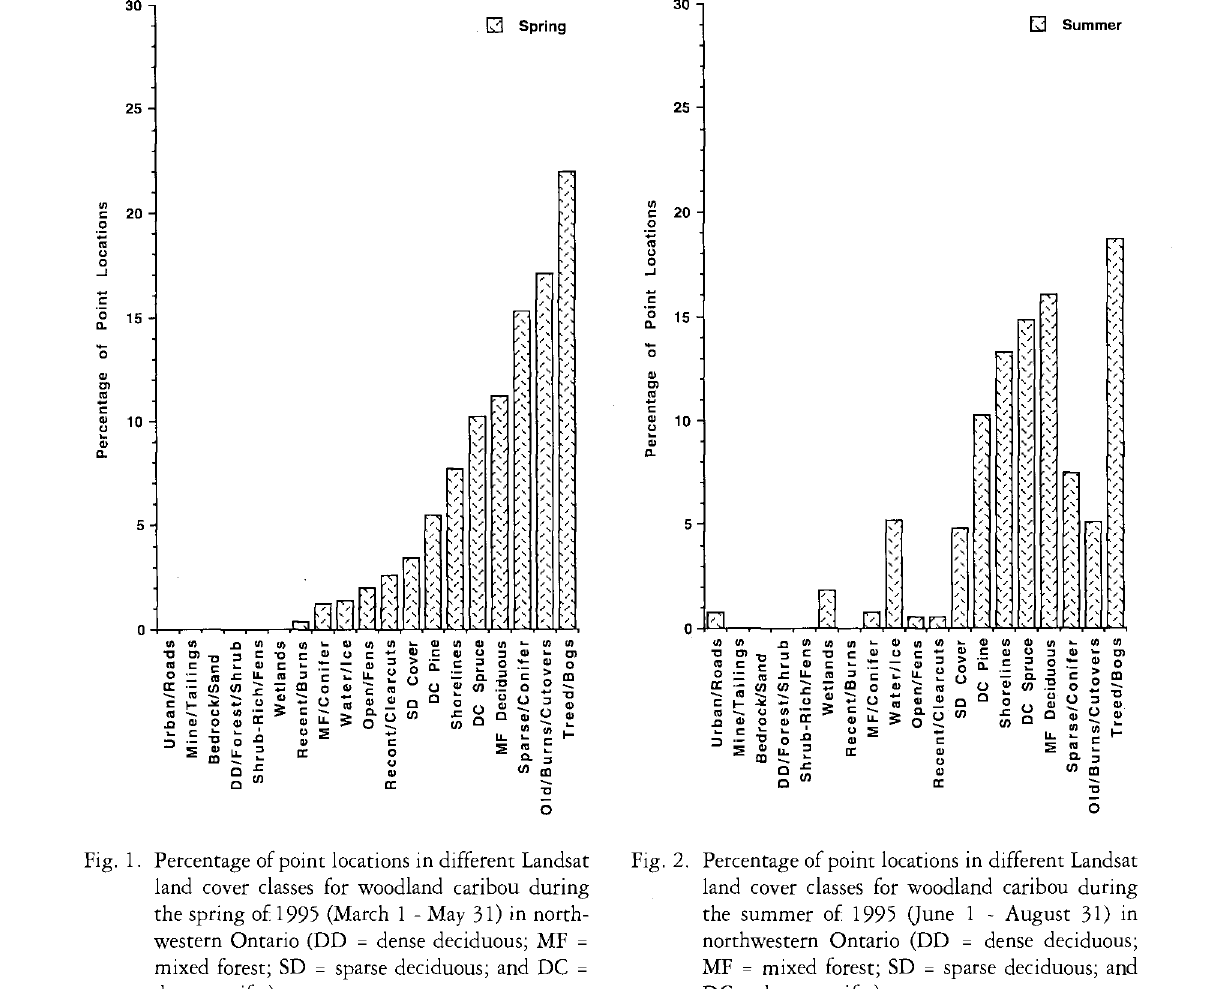
Fig. 1. Percentage of point locations in different Landsat land cover classes for woodland caribou during the spring of 1995 (March 1 - May 31) in north western Ontario (DD = dense deciduous; MF = mixed forest; SD = sparse deciduous; and DC = dense conifer).